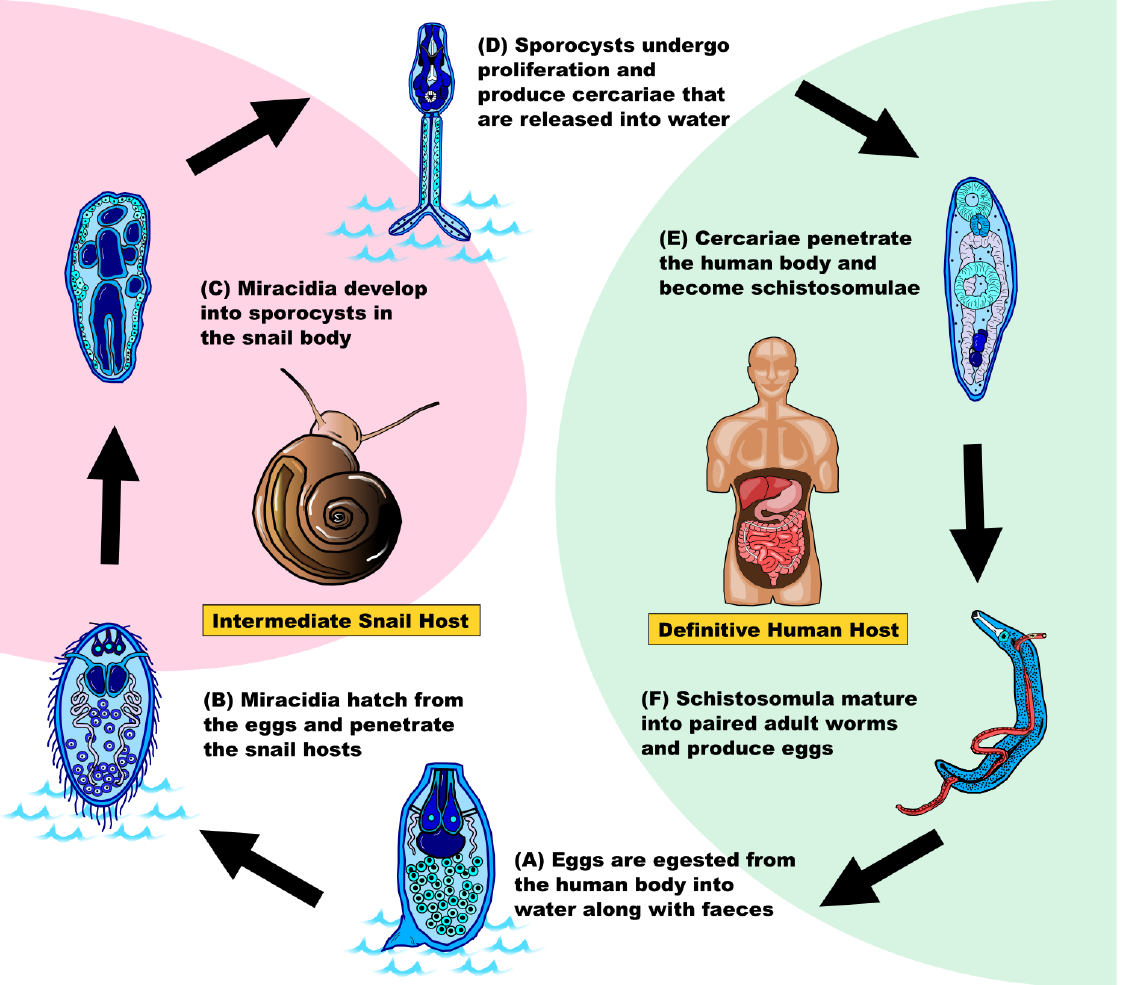
Figure 1. Schematic diagram showing the lifecycle of Schistosoma mansoni (after [3,5 – 7]). Pink shading indicates the lifecycle in the intermediate snail host Biomphalaria , white shading indicates the lifecycle in the aquatic environment, and green shading indicates the lifecycle in the definitive human host. ( A ) Egg. ( B ) Ciliated miracidium. ( C ) Sporocyst (mother sporocyst and daughter sporocyst). ( D ) Free-living cercariae. ( E ) Schistosomulae. ( F ) Paired adult worms (male: blue; female: red).